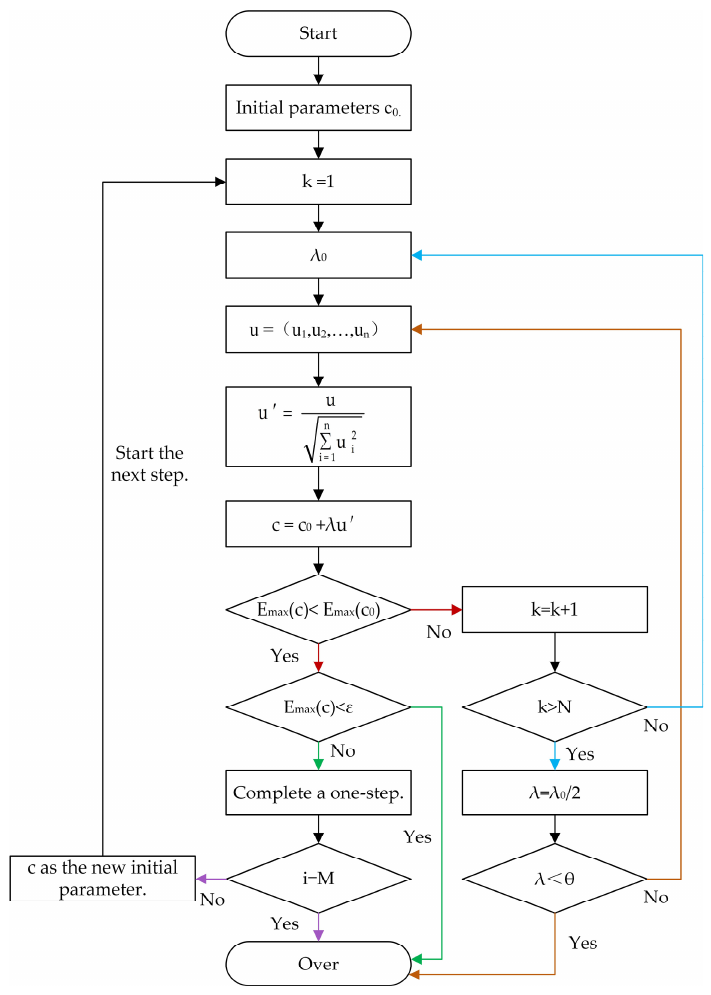
Figure 1. Flow chart of the algorithm.